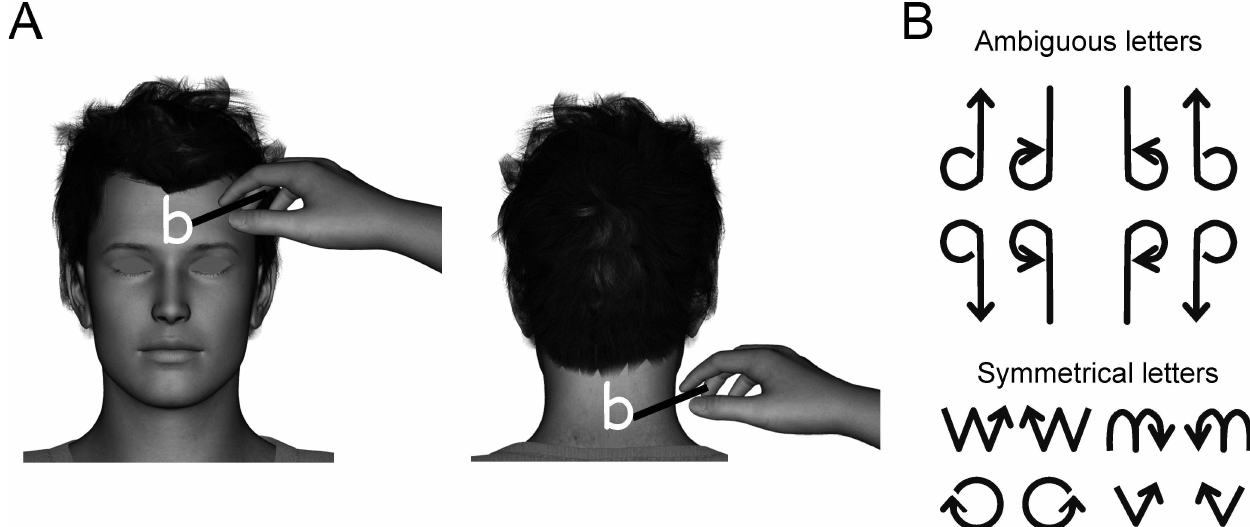
Fig 4. Methods for the graphaesthesia task (Experiment 2). (A) The experimenter drew letters on the participants’ forehead and neck by using a cotton bud whileparticipantskept their eyes closed. (B) Letters includedambiguous, non-symmetrical letters (b, d, p, q) and non- ambiguous, symmetrical letters (w, n, o, v) that were all drawn in the canonicaldirection of writing or in the reverse direction, starting from the opposite end of the letter. All letters were drawn by using a single and continuoushand